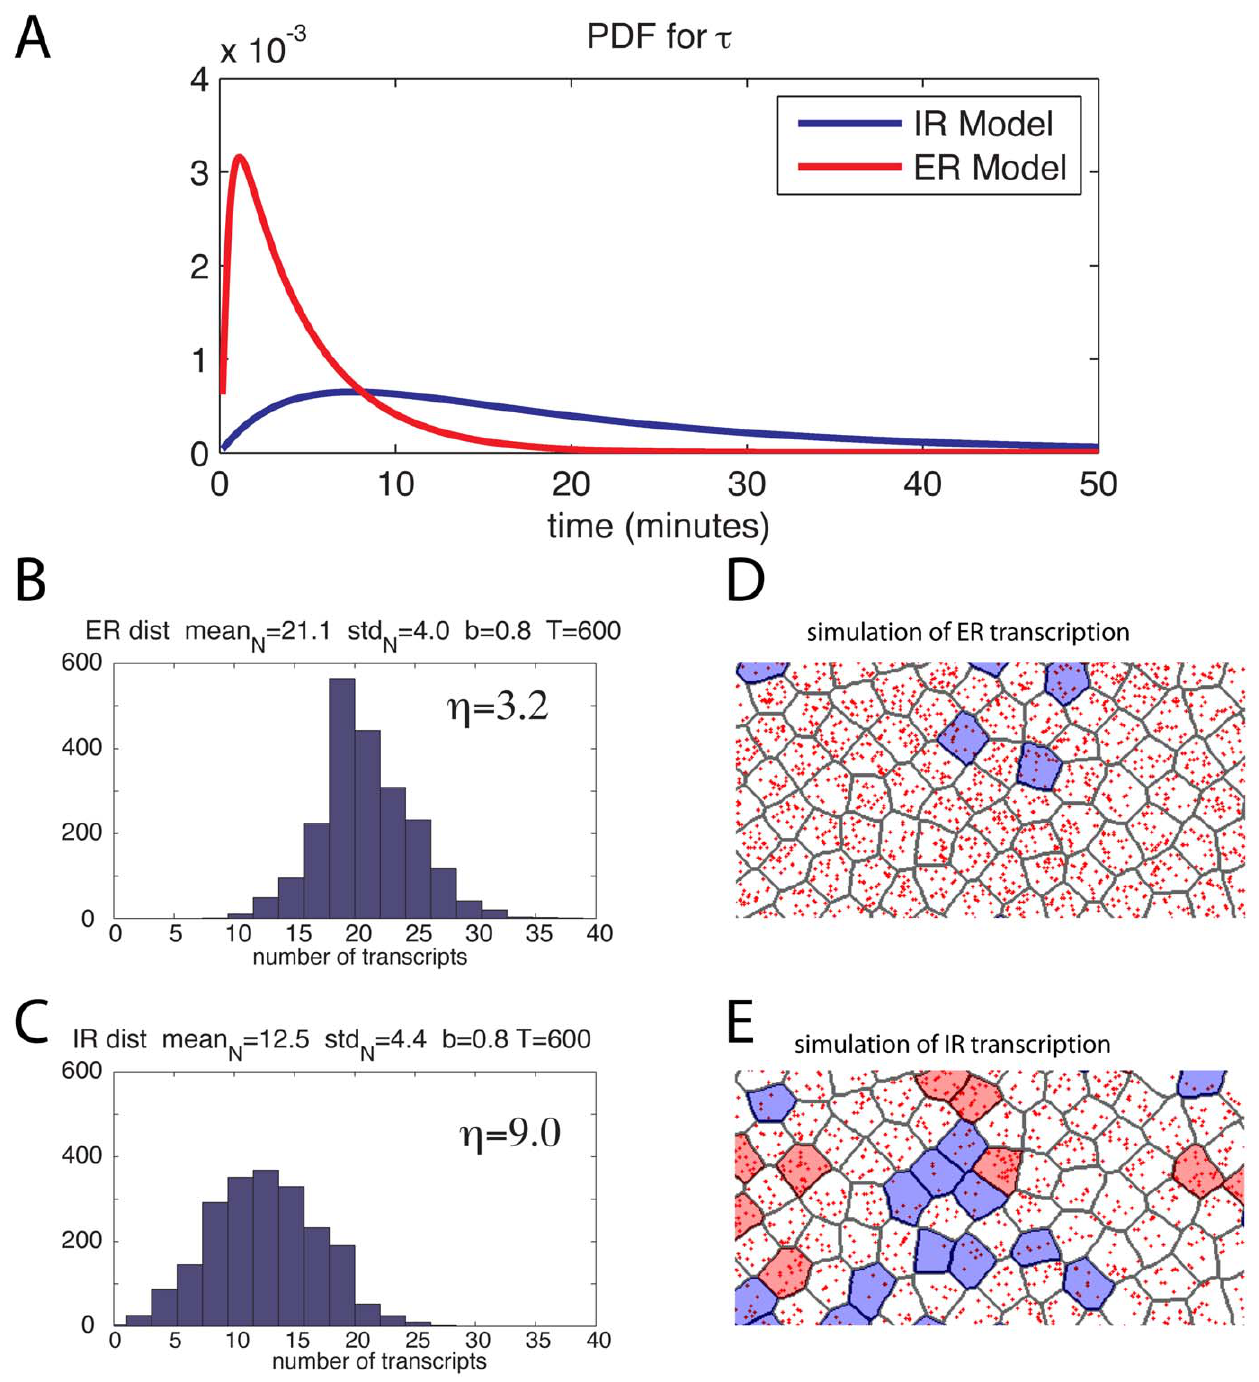
Figure 3. Model predictions. ( A ) Probability distributions for first passage times: Probability density functions of the time to first transcription, obtained by inversion of symbolically calculated Laplace transforms, using rate parameters computed in experimental studies of particular transcription systems. Rates inferred from Darzacq et al. [17] measurements of promoter binding and promoter escape rates (see text). ( B ) Distribution of total transcripts among a population of simulated cells during 600 minutes of transcription under the ER model with parameters as in (A) and a reinitiation probability of 0.8. ( C ) as in (B) but for the IR model. ( D ) Individual cell simulation (see text) showing of the expected results for an mRNA counting assay on the population of cells plotted in (B). Each mRNA transcript is represented by a red dot randomly positioned within the cell. Cells with less than two-thirds of mean mRNA concentration are shaded blue, cells with more than three-halves of mean mRNA concentration are shaded red. ( E ) as in (D) but for the IR scheme.